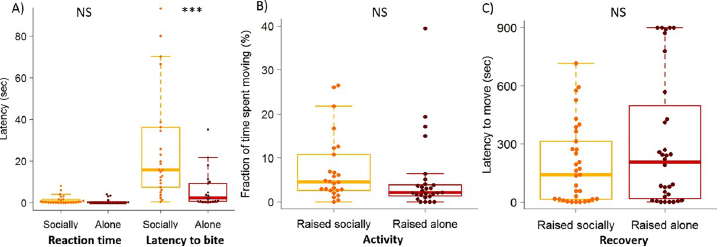
Fig 6. Social isolation influences aggressiveness toward a prey but not the activity level nor the latency to recover after an aversive stimulation. (A) Reaction time and latency to bite a prey introduced to a test arena containing a single spiderling raised socially ( N = 22) or in isolation ( N = 21) for 15 days before the test. (B) Fraction of time spent moving by single spiderlings in an open arena (diameter: 55 mm) for 30 min after they were raised alone (N = 27) or in groups ( N = 26) for 15 days. (C) Latencies to resume activity after being stimulated with an air puff for individuals raised socially ( N = 33) or alone ( N = 32). In each box plot, a dot indicates the score of each spiderling. Horizontal line in each box represents the median, and the lower and upper hinges indicate the first and third quartiles. Lower and higher whiskers extend to the most extreme values within 1.5 interquartile ranges from the first and third quartiles respectively. Significant difference is indicated by ��� ( t test, P < 0.001), NS indicates non-significant differences. Relevant data values are included in S1